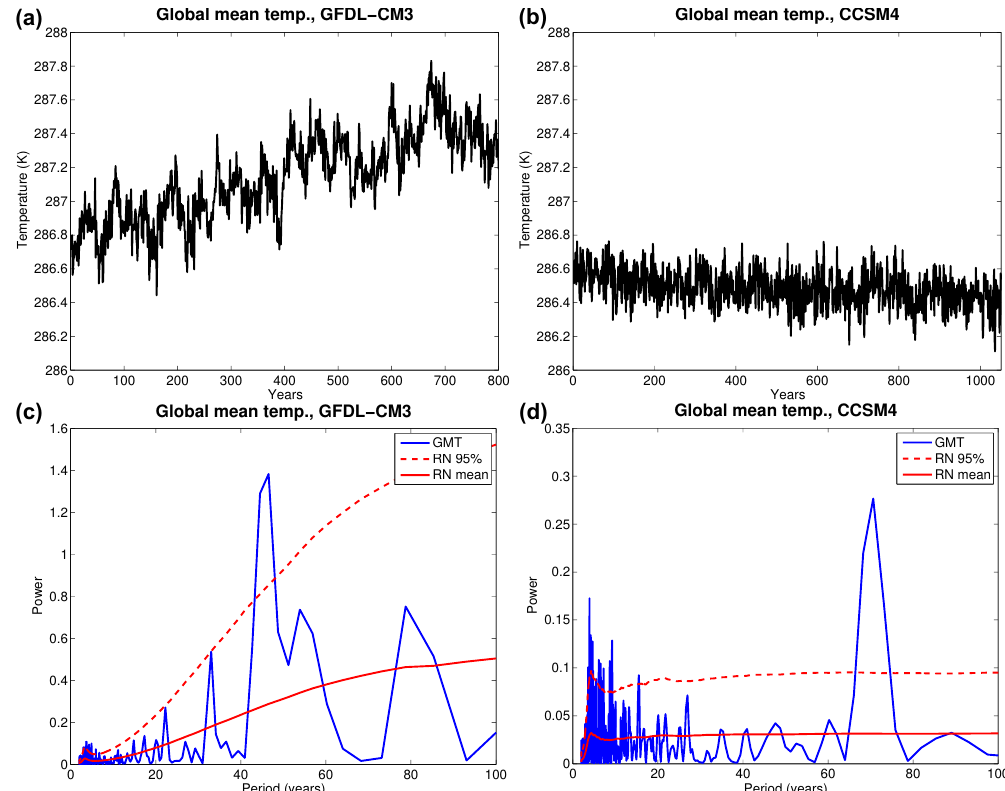
Figure 2. Characterization of the global-mean 2m air temperature variables used in this paper. Panels (a) and (b) show the global-mean temperature time series for the preindustrial control simulations of GFDL-CM3 and CCSM4, respectively. Panels (c) and (d) show their respective power spectra (GMT) with a best-fit red noise (RN) spectrum (computed as in Schneider and Neumaier, 2001) and an estimated 95% confidence